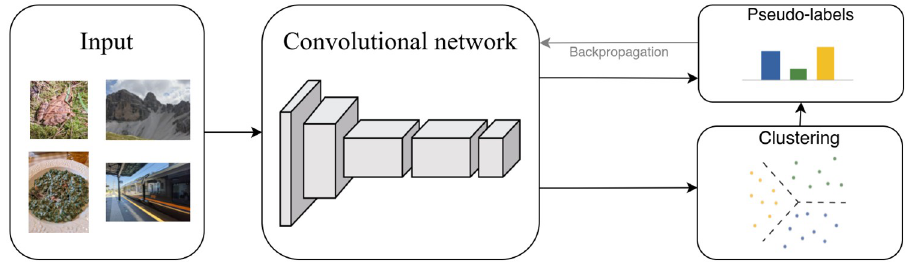
Fig 4. DeepCluster structure